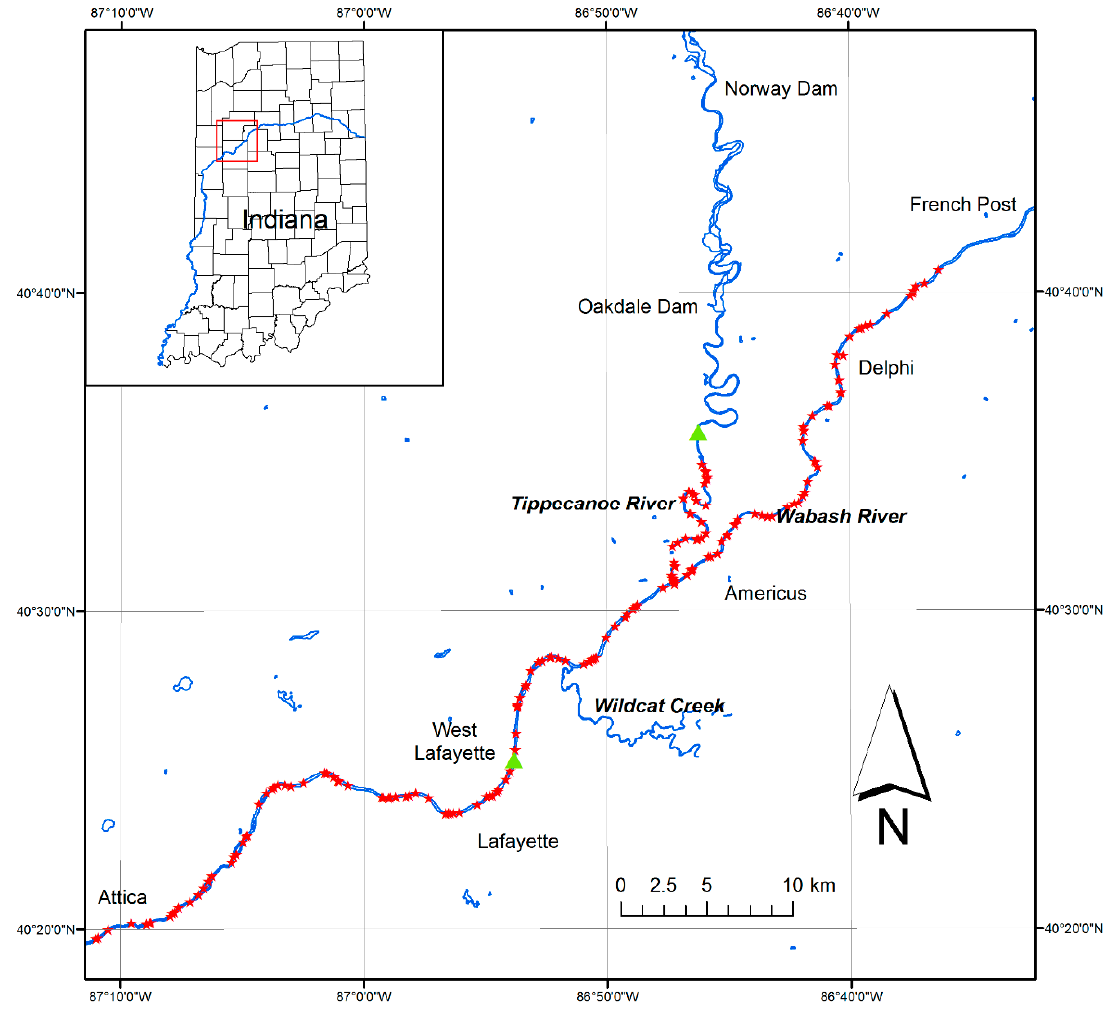
Figure 1. Main study area includes two reaches of the Wabash River, including the confluence with the Tippecanoe River. Field spectrometer measurements and water samples (marked as red stars) were collected through the summer of 2014. Triangles indicate United Stated Geological Survey (USGS) real-time streamflow monitoring stations.